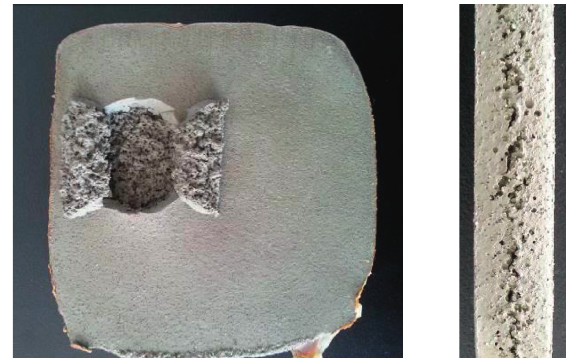
Figure 3: The state diagram of NEPE after accelerated